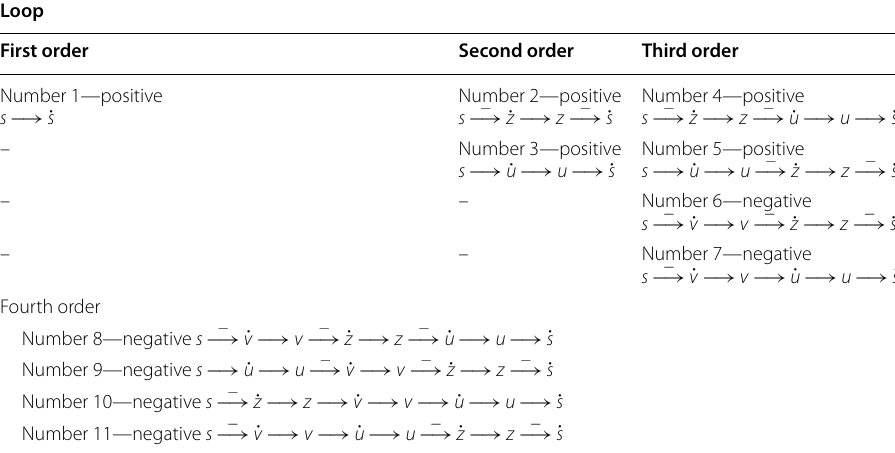
The strongest greed feedback loop R2 in L-1 is present in L-2 too